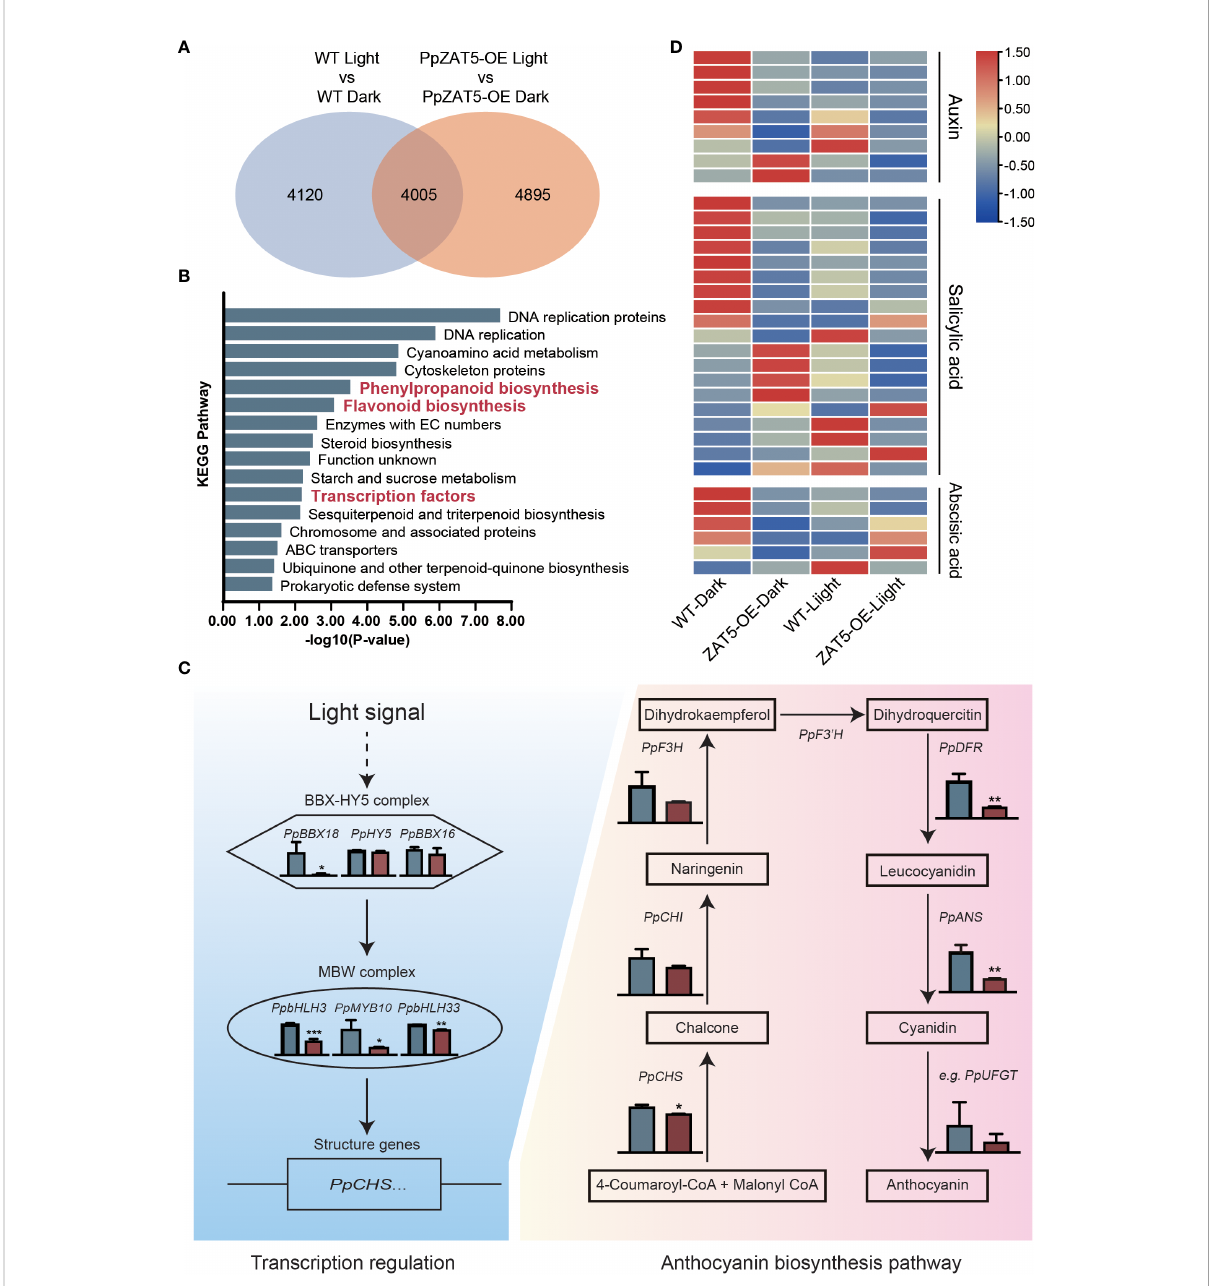
FIGURE 5 RNA-Seq analysis of PpZAT5 overexpression calli under light conditions. (A) The Venn graph of the numbers of differential expression genes between wild-type and PpZAT5 overexpression calli under dark/light conditions. (B) The enrichment analysis of KEGG pathways in the differential expression genes between wild-type and PpZAT5 overexpression calli under light condition. (C) FPKM value of genes involved in light-induced anthocyanin biosynthesis in wild-type and PpZAT5 -OE pear calli under light treatment. Blue color represents wild-type pear calli, red color represents PpZAT5 overexpression pear calli. (D) The heatmap of differential expression genes involved in the phytohormone pathway between wild-type and PpZAT5 overexpression calli under dark and light conditions. Error bars for the FPKM value represent the standard deviation of three independent experiments. Asterisks indicate signi fi cant differences (two-tailed Student ’ s t -test, *P < 0.05, **P < 0.01, ***P <